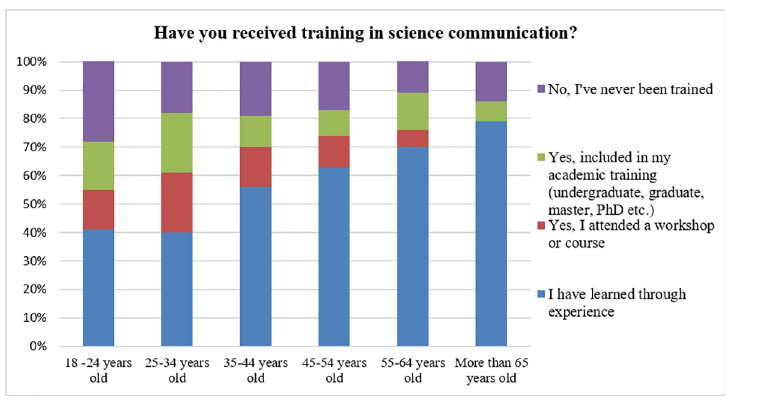
Fig 3. Training in scientific communication.